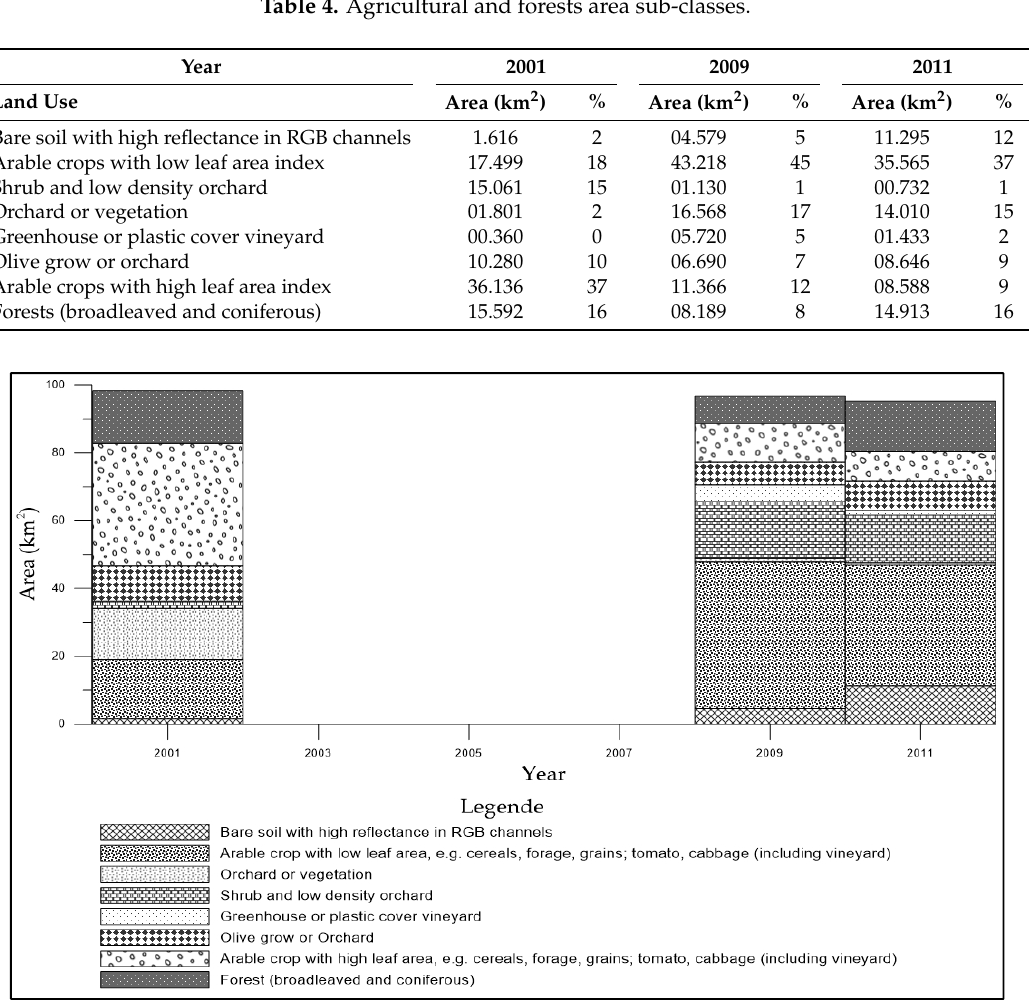
Figure 4. Agricultural pattern and forests area variation (2001–2011).